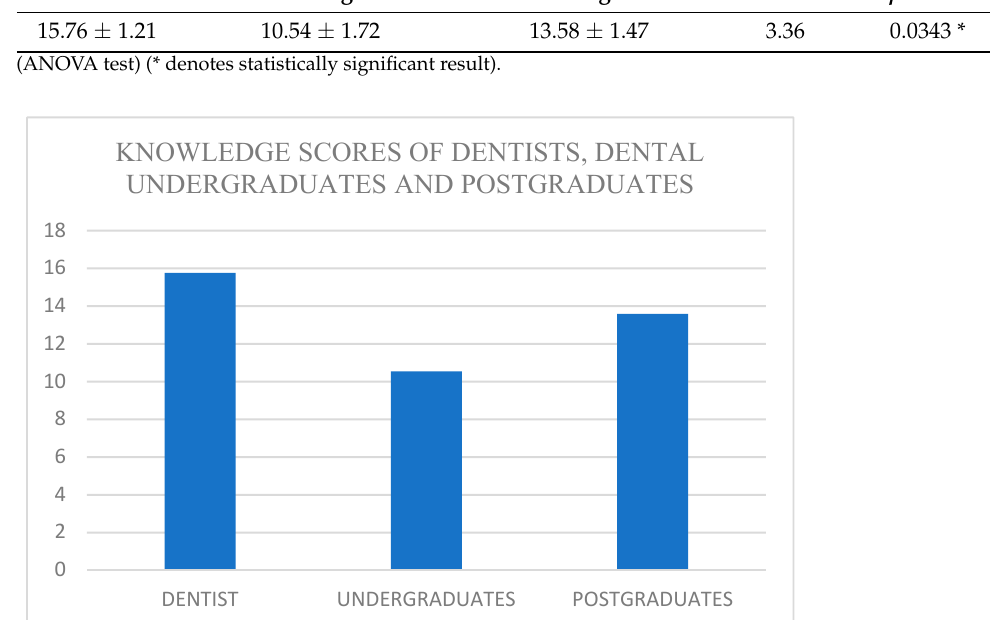
Figure 3. Knowledge scores of dentists, dental undergraduates, and postgraduates.